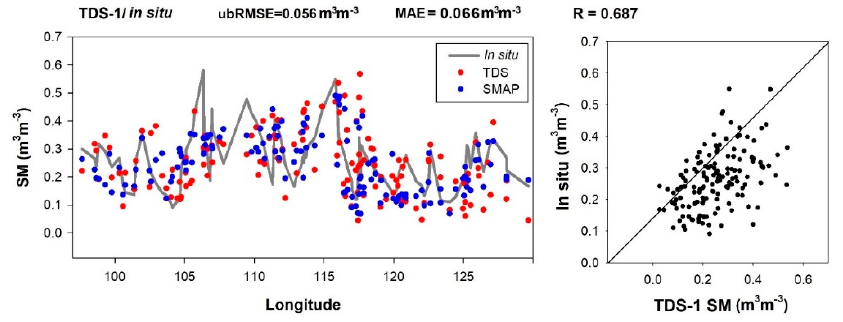
Figure 10. Correlations of the SM derived from TDS-1, SMAP SM, and in situ measurements for locations with longitudes between 95.9° to 129.8° in April 2018.